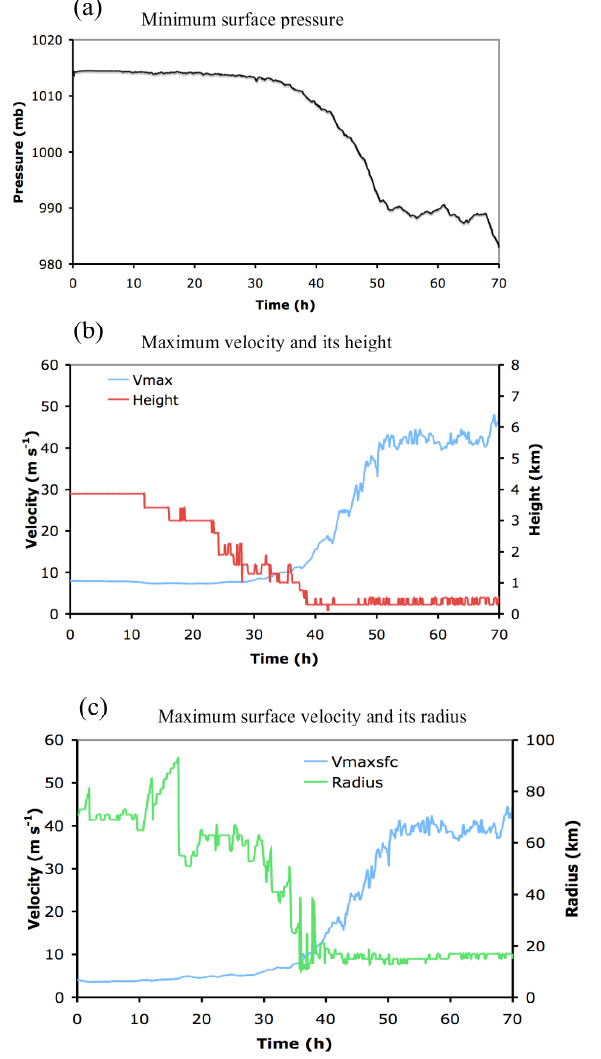
Figure 3. Time series for Experiment 1, the no ice case. (a) The minimum surface Fig. 3. Time series for Experiment 1, the no ice case. (a) The mini- pressure. (b) The azimuthally averaged maximum tangential velocity and the height it mum surface pressure. (b) The azimuthally averaged maximum tan- occurs. (c) The azimuthally averaged tangential velocity at the lowest model level and gential velocity and the height it occurs. (c) The azimuthally aver- the radius it occurs. aged tangential velocity at the lowest model level and the radius it occurs.